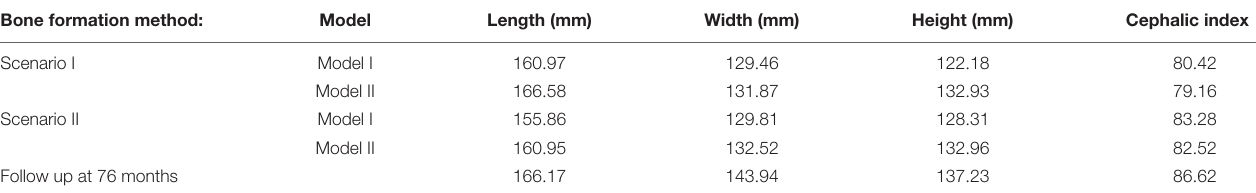
FIGURE 3 | Bone formation rate sensitivity at various stages, sagittal and dorsal views. TABLE 3 | Summary of various Cerebrospinal fluid (CSF) model under each respective bone formation